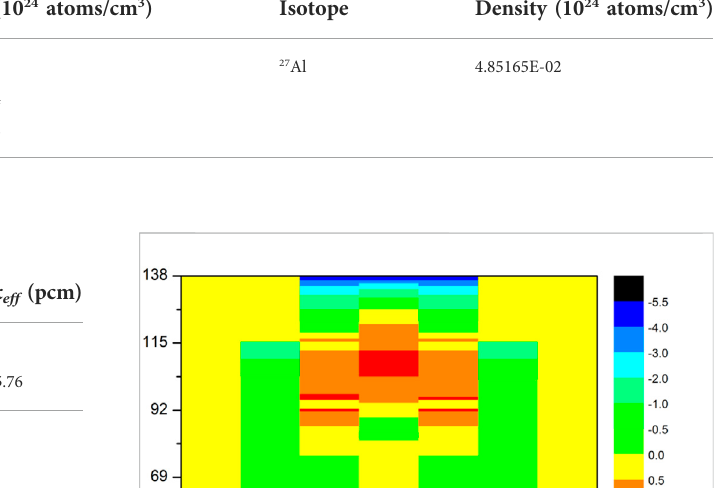
TABLE 9 k eff for MTR core (HEU).